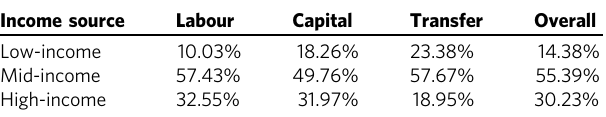
Table 1 Ratios of income sources for household